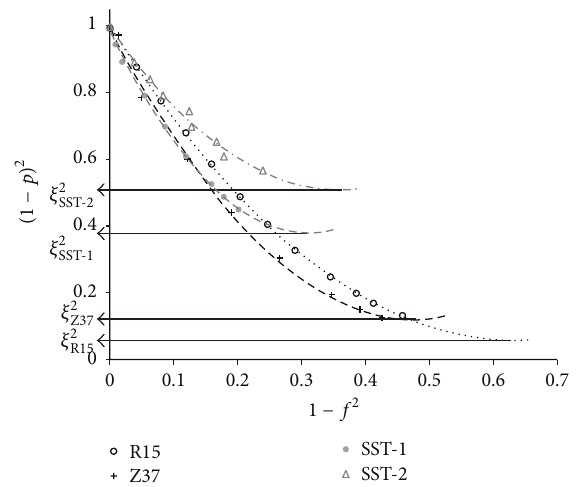
Figure 8: Plot of (1 − 𝑝) 2 versus ( 1 − 𝑓 2 ) and 2nd-order fit for each tested